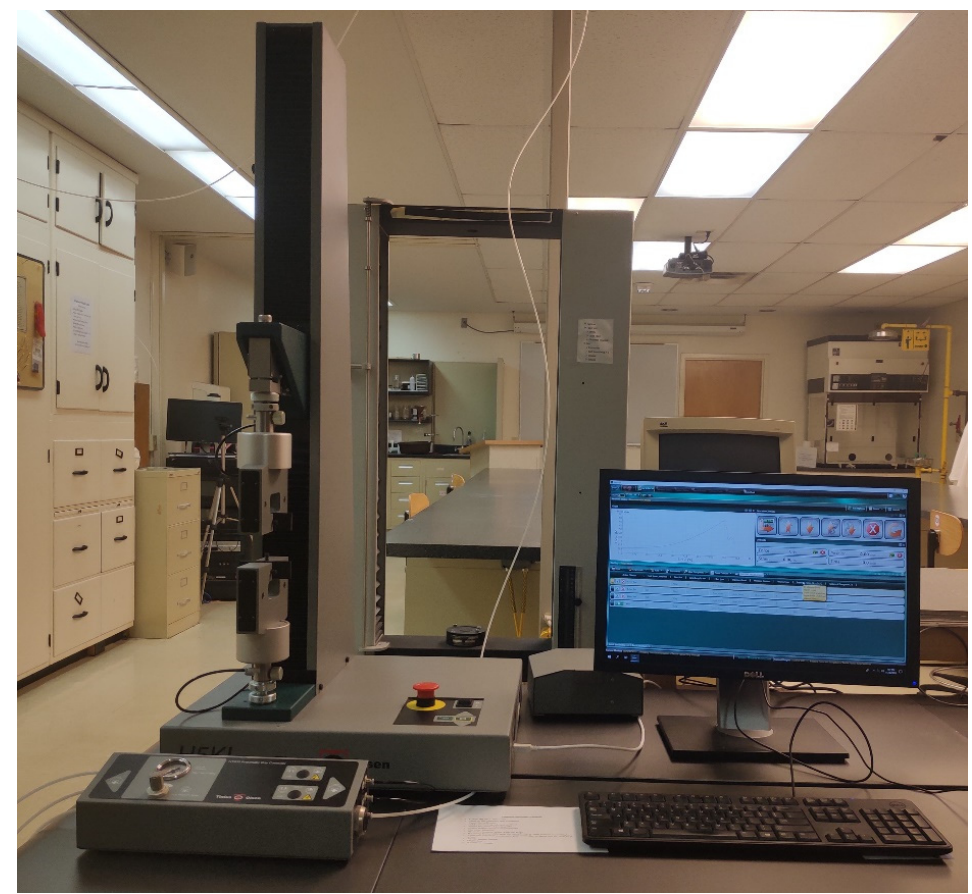
Figure 4. Tensile strength tester